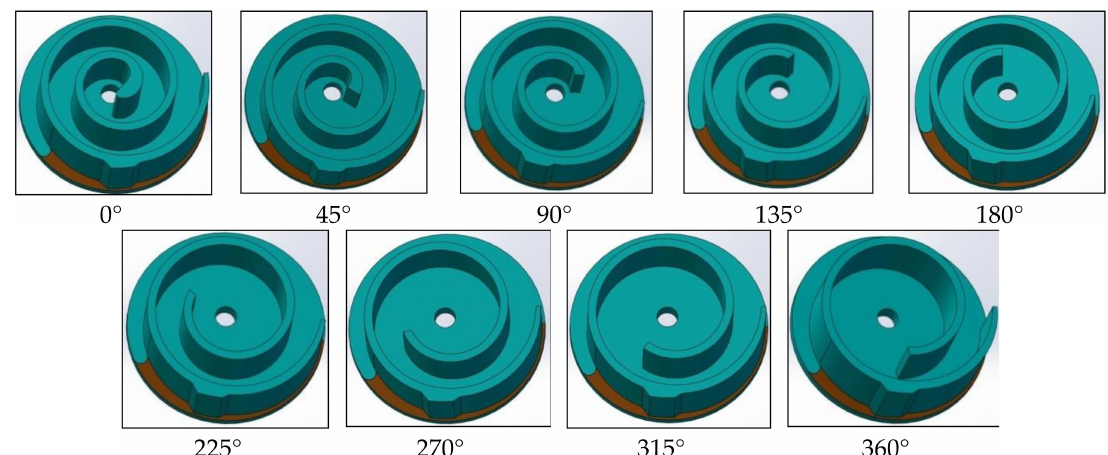
Figure 6. Di ff erent cutting angle diagrams of intake chamber wall.